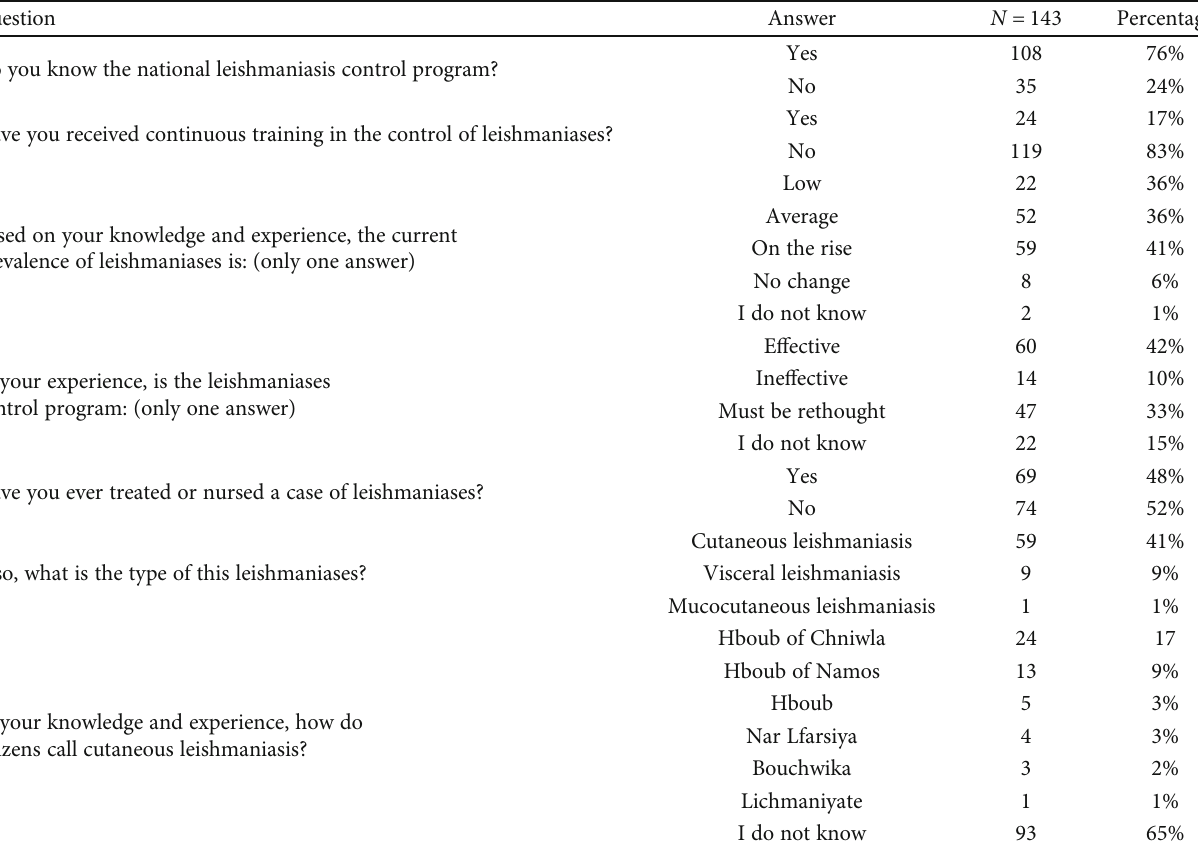
Table 3: Knowledge of the national program for the control of